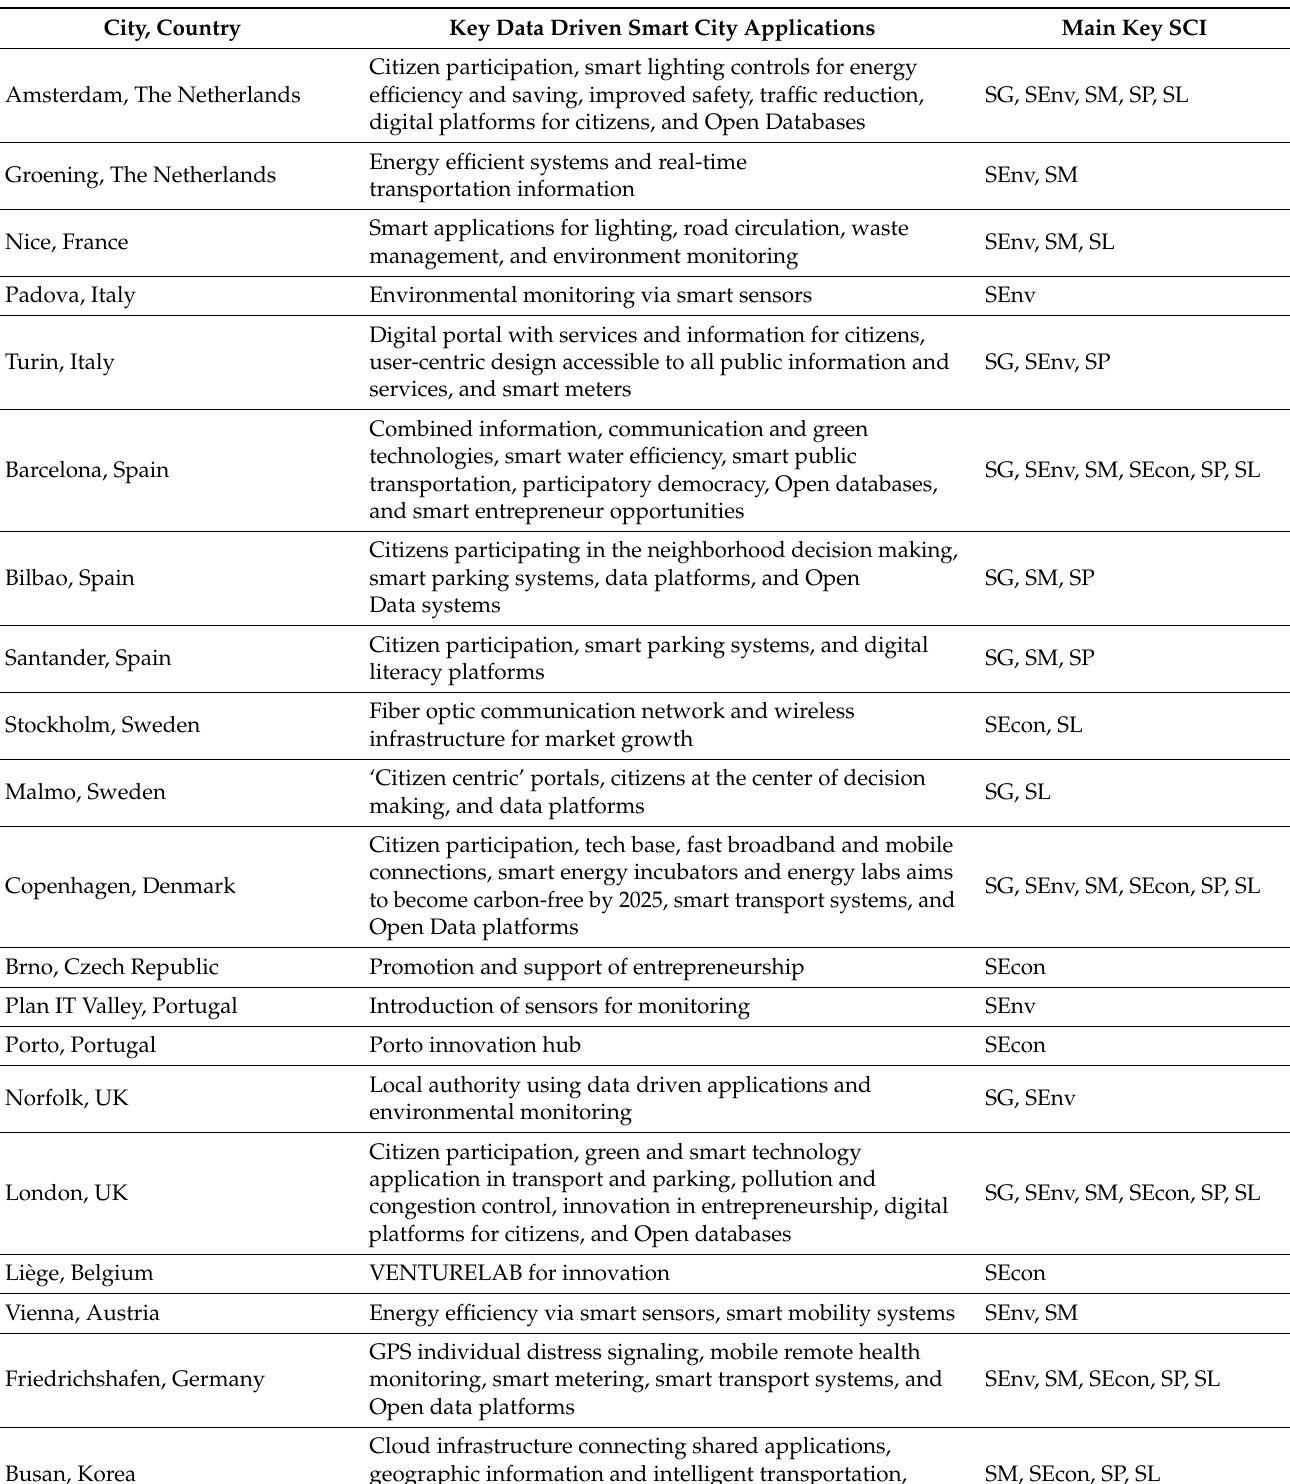
Table A1. Global smart city applications, categorized according to the smart city